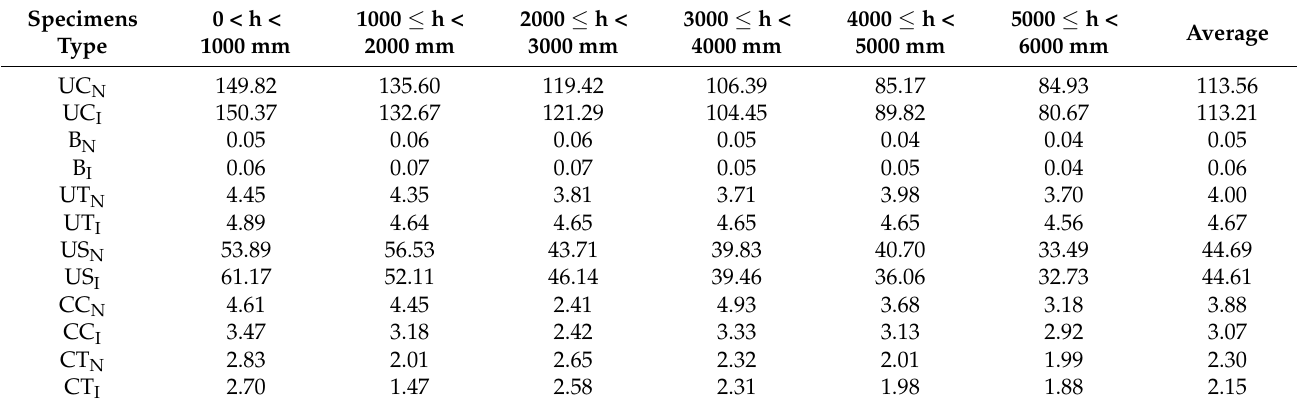
Table 1. Bearing capacity